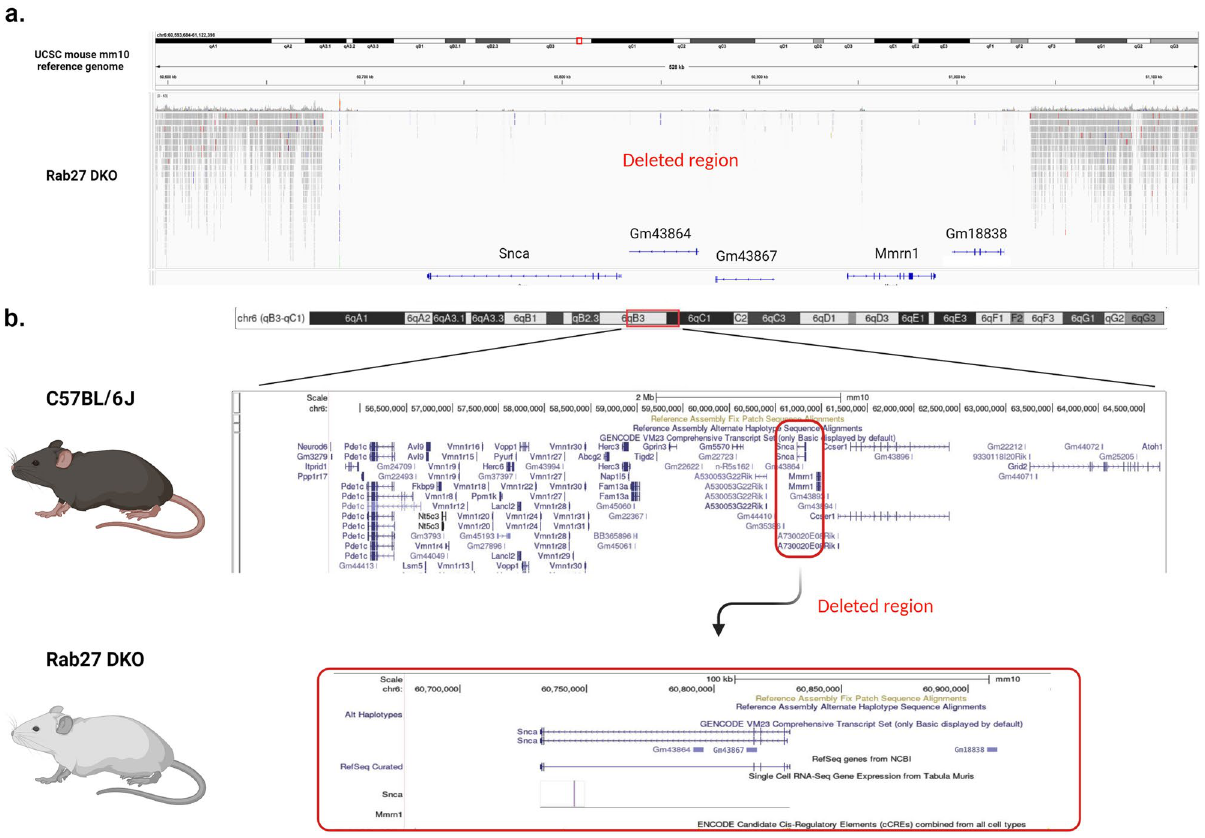
Figure 3. Rab27 DKO mice have a ~ 360 kb deletion on chromosome 6. ( a ) Representative view for the deletion region from the Integrative Genomics Viewer (IGV) for the Rab27 DKO mice aligned to the UCSC mouse reference genome mm10. ( b ) Model demonstrates deletion region involving the Snca and Mmrn1 loci on chromosome 6 in the Rab27 DKO